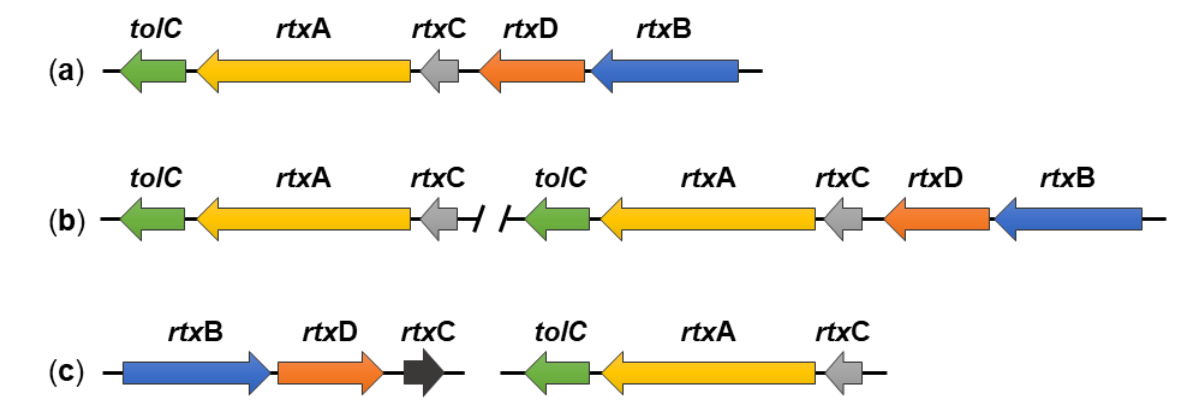
Figure 3. The schematic representation of the rtx gene loci of different K. kingae strains. The rtx loci of K. kingae strain 269 – 492 ( a ), K. kingae strains ATCC 23332 and KWG1 ( b ), K. kingae strains ATCC 23331 and NCTC 10529 ( c ). The colored arrows represent coding regions and transcriptional directions of the rtx genes encoding the protoxin proRtxA (yellow), the acyltransferase RtxC (light gray, a 167 residue-long variant; dark gray, a 162 residue-long variant), and the proteins of the T1SS apparatus (blue, ABC transporter; orange, MFP; green, OMF).